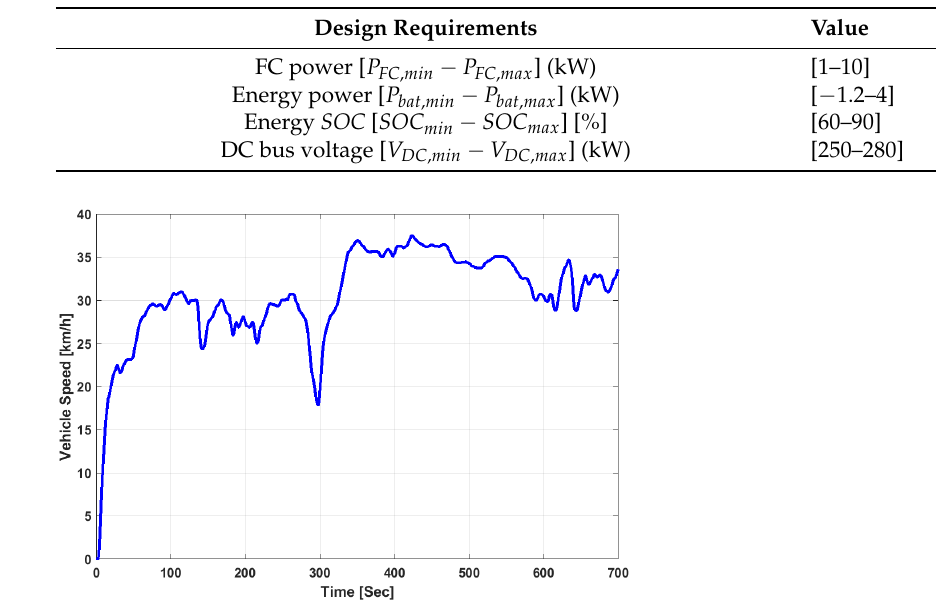
Table 3. Energy management design requirements.